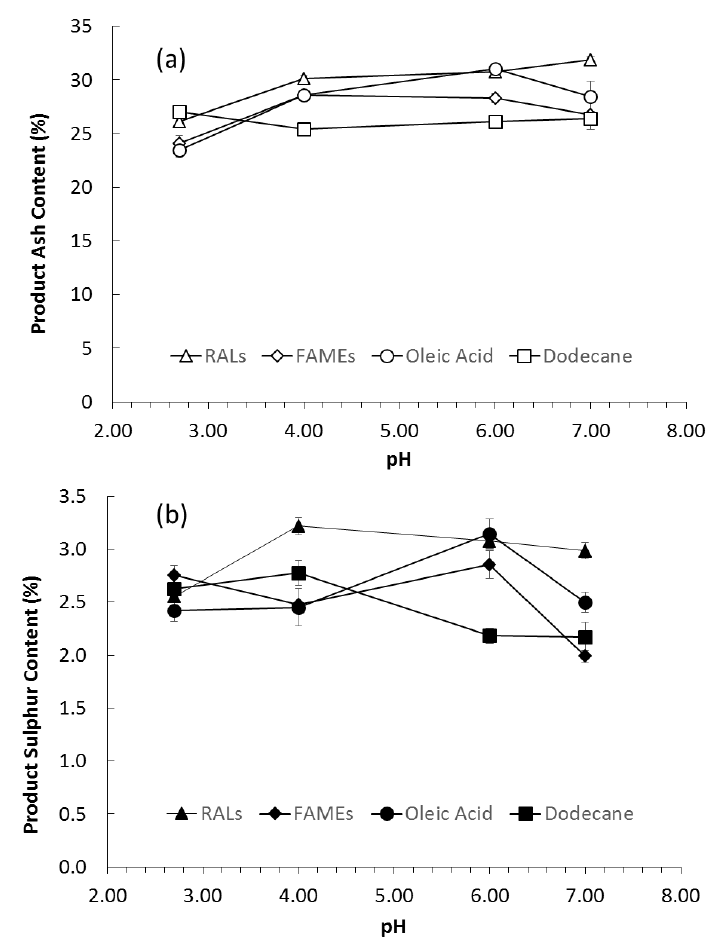
Figure 7. The ( a ) ash and ( b ) sulphur content of the product obtained using RALs, FAMEs, oleic acid, and dodecane collectors at a fixed dosage of 2.79 kg/t.